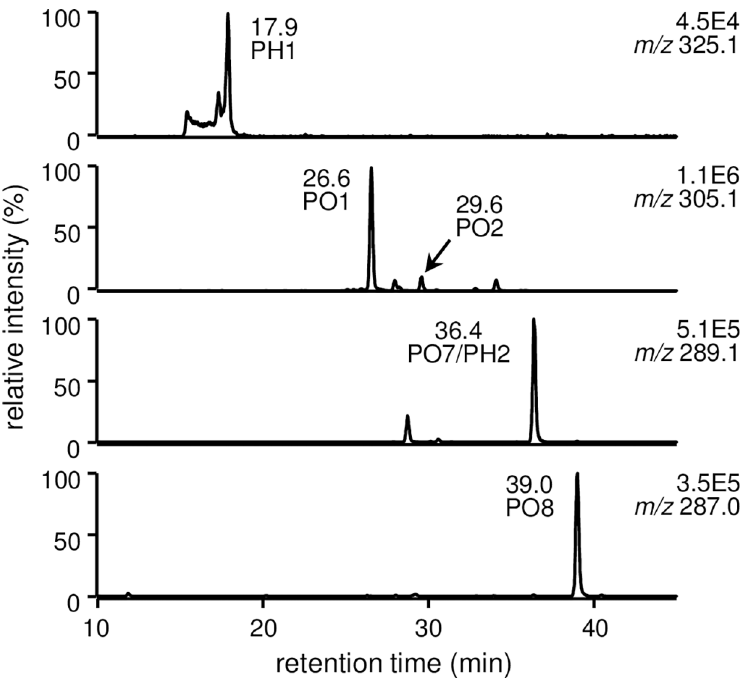
Fig 7. LC/ESI-MS analysis of PM-ONE/HNE adducts in the reaction between HSA and 13-HPODE in the presence of AscA and PM.